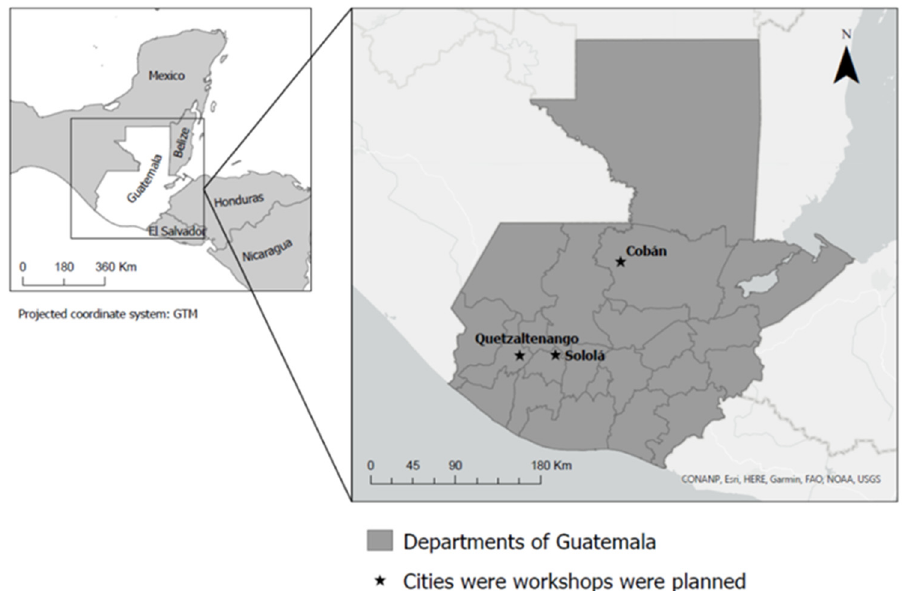
Figure 1. Cities of Guatemala where climate services for agriculture workshops were planned. GIS layers source: UN Office for the Coordination of Humanitarian Affairs—Field Information Services.